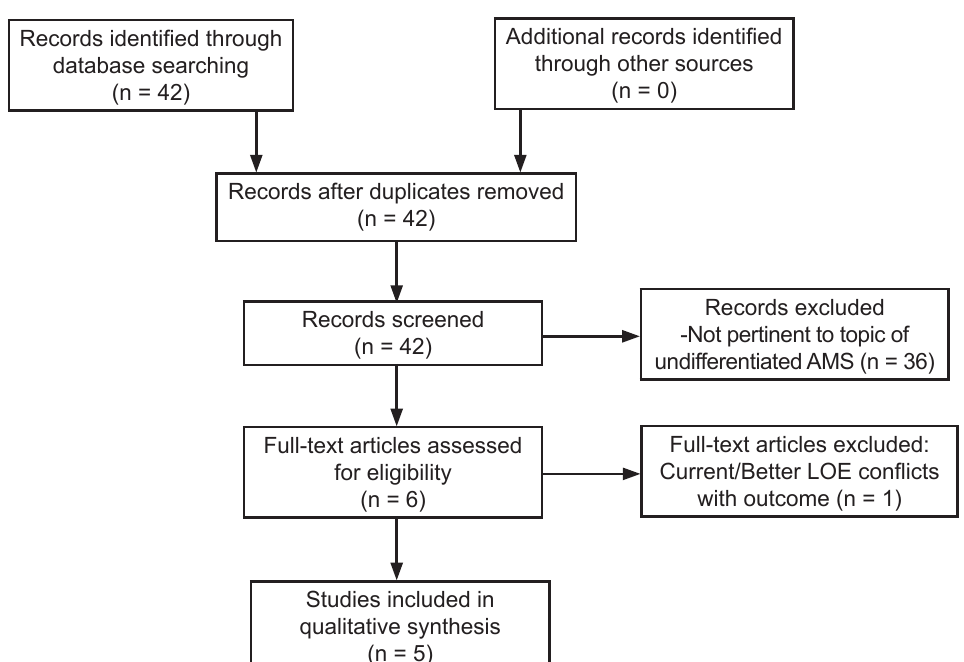
Figure. Preferred Reporting Items for Systematic reviews and Meta-Analyses (PRISMA) diagram based on initial PubMed search term “Prehospital and Altered Mental Status”. AMS, altered mental